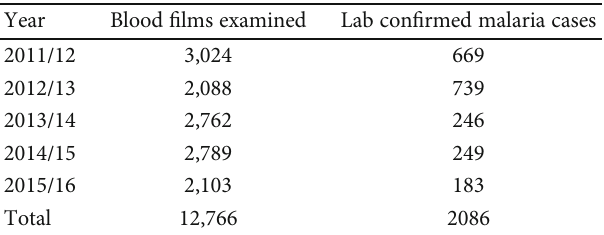
Table 1: Annual trends in total malaria cases in Dembecha Health Center, northwestern Ethiopia